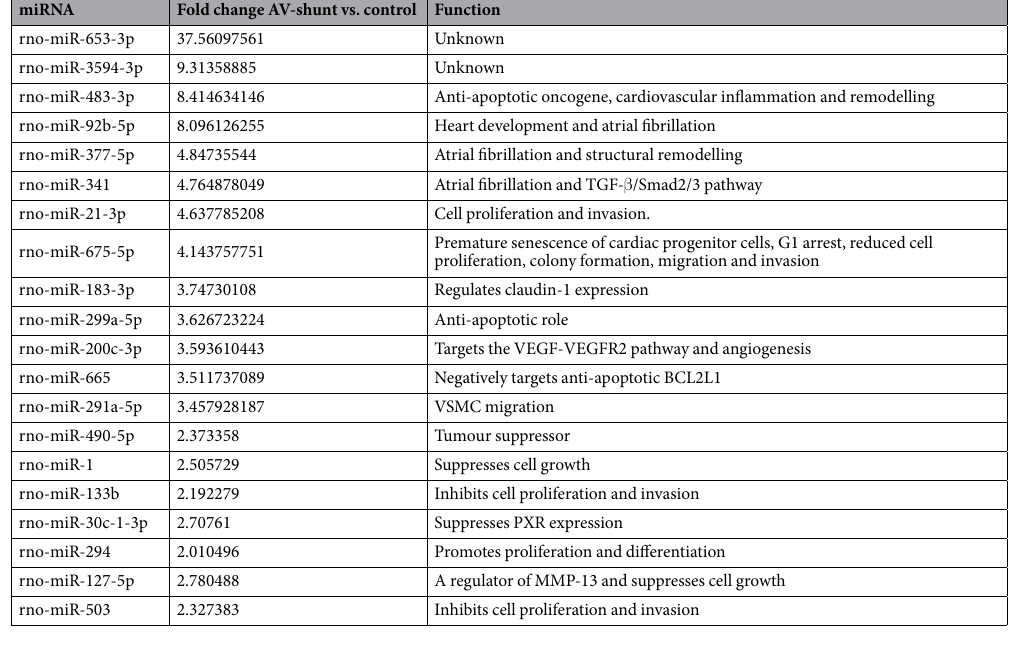
Table 1. Twenty up-regulated